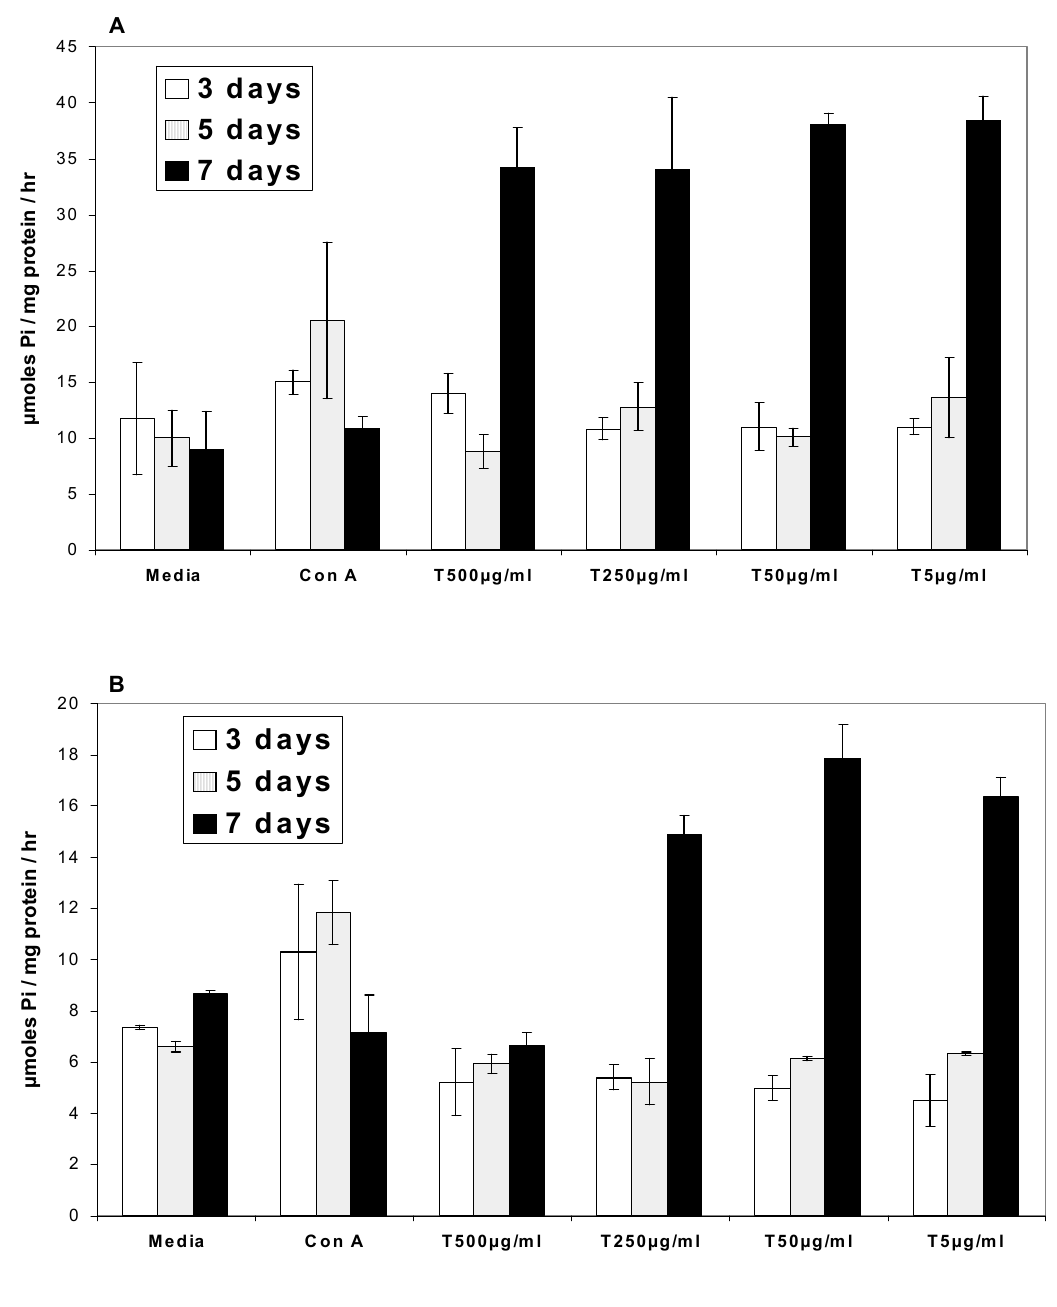
Figure 1. ATPases activity of human mononuclear cells stimulated with Con A after 3, 5 and 7 days of incubation with turmeric (T). The enzyme activity of cells in media alone is compared with the activity of cells in Con A alone and in Con A + T (500, 250, 50 and 5 µg/ml). (A) represents the Ca 2+ ATPase activity. (B) represents the Na/K + ATPase